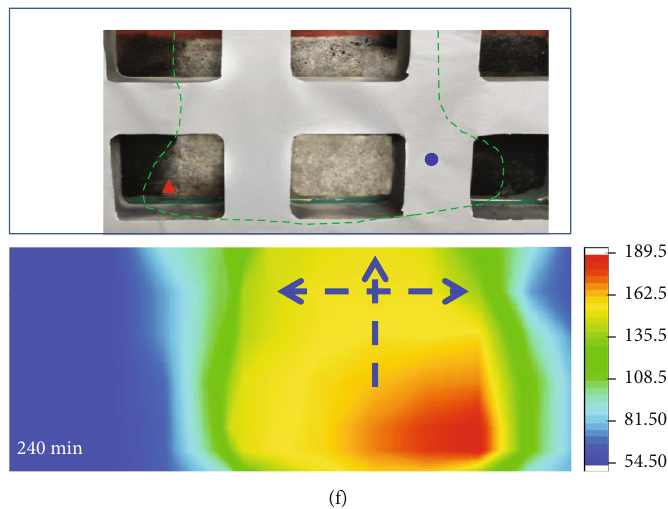
Figure 13: Pictures of steam chamber development and corresponding temperature pro fi